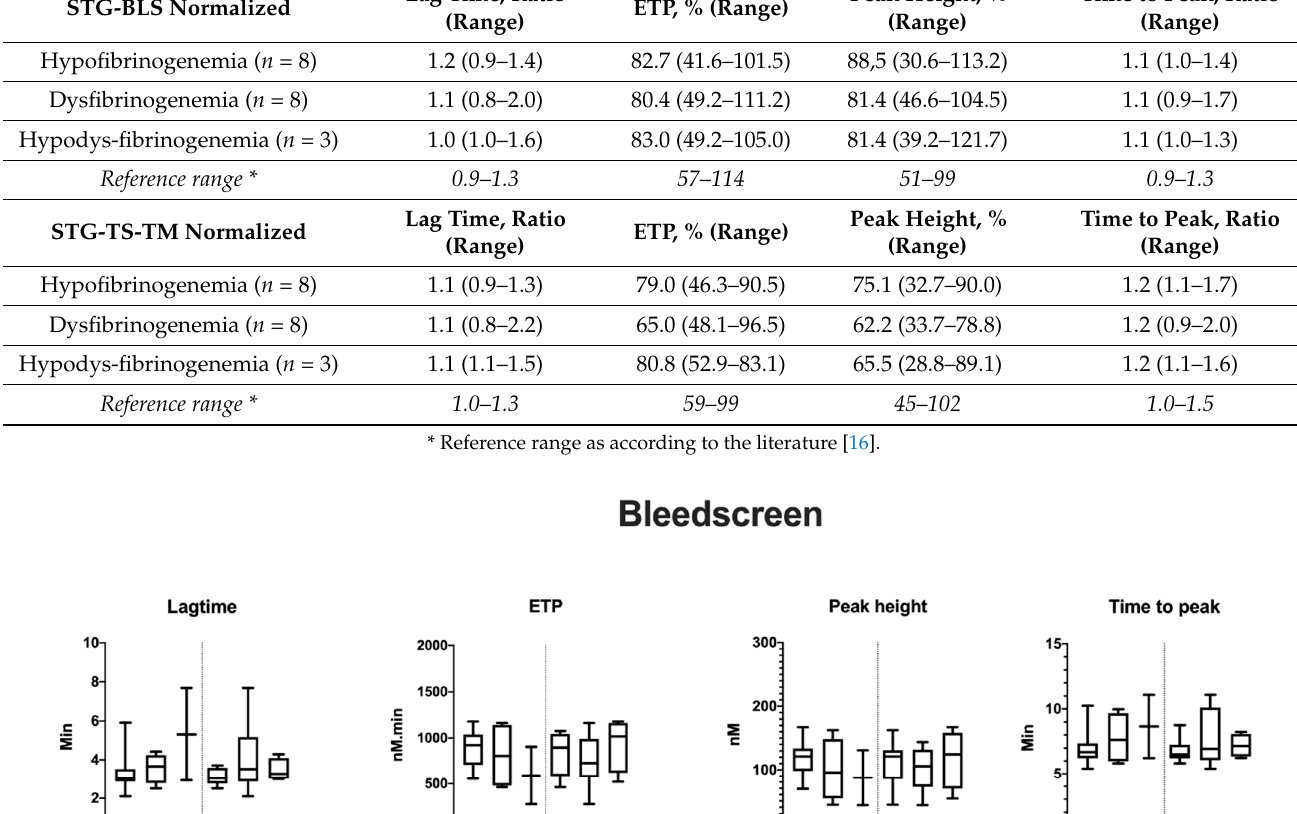
Table 2. Mean normalized TG variables with STG-BLS and STG-TS in the absence of thrombomodulin according to clinical and laboratory phenotypes.